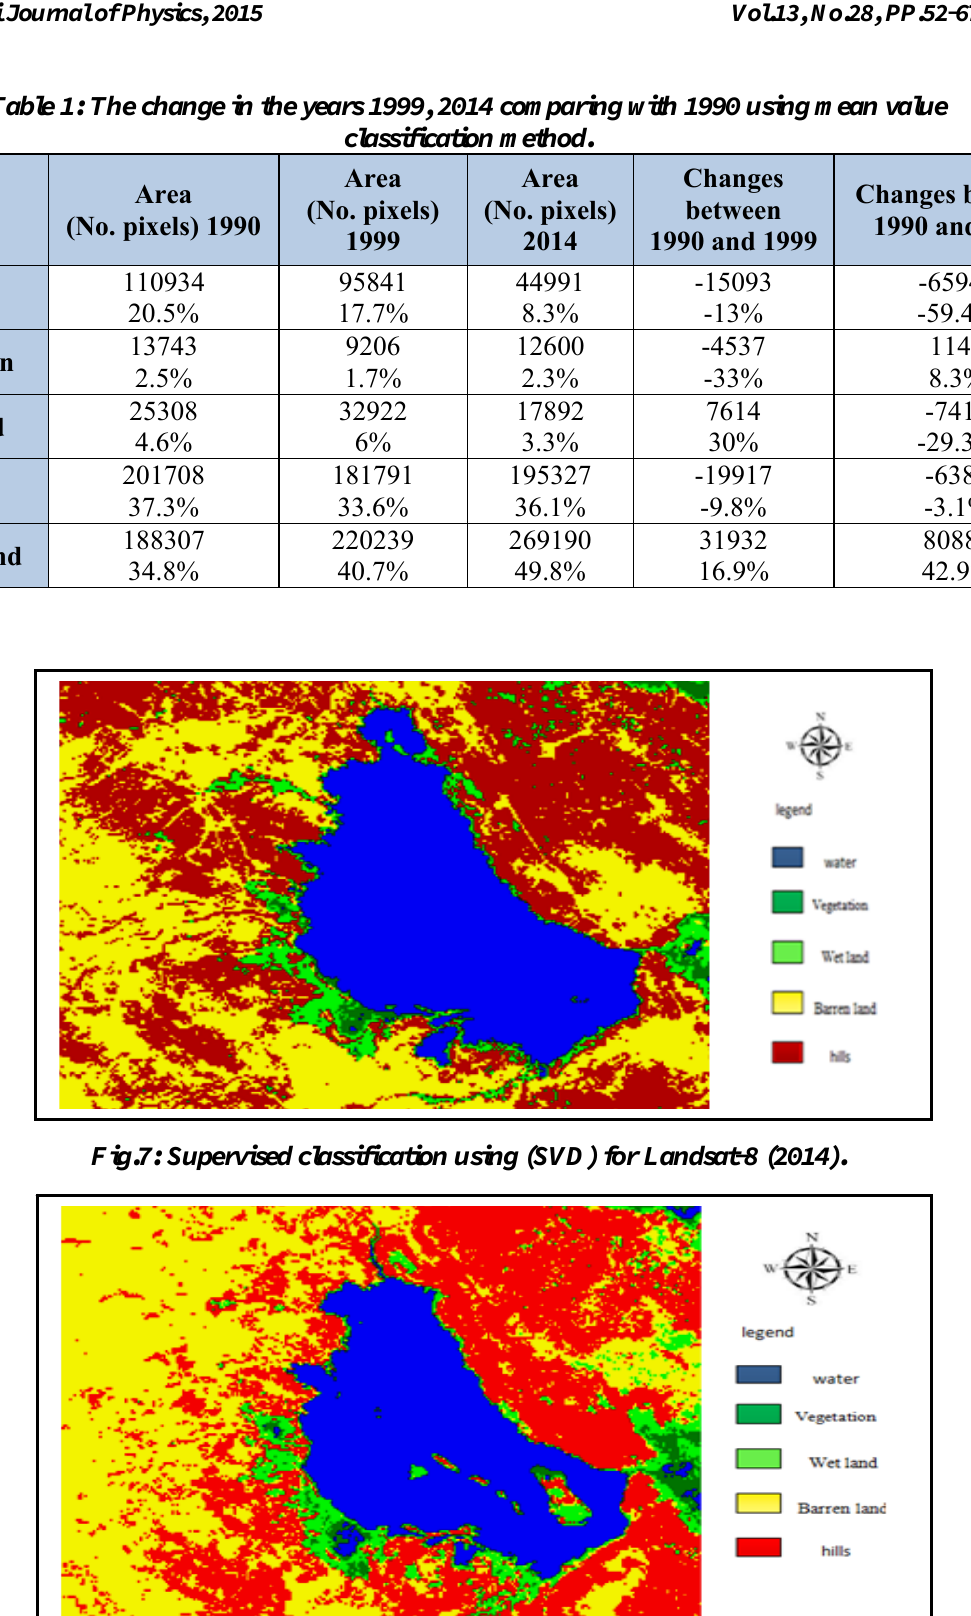
Fig.8: Supervised classification using (SVD) for Landsat-7